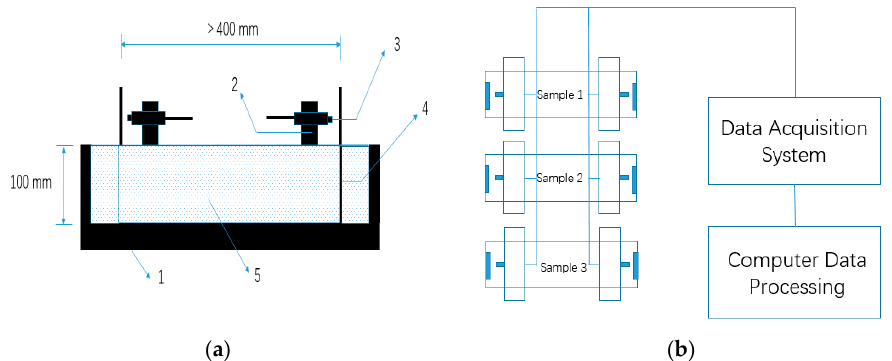
Figure 3. Autogenous shrinkage test method for alkali-activated slag concrete (AASC): ( a ) Non-contact concrete shrinkage deformation test system. 1. Steel mold; 2. Sensor support; 3. Eddy-current displacement sensor (ECDS) 4. Standard target; 5. Concrete mixture, and ( b ) Schematic diagram of